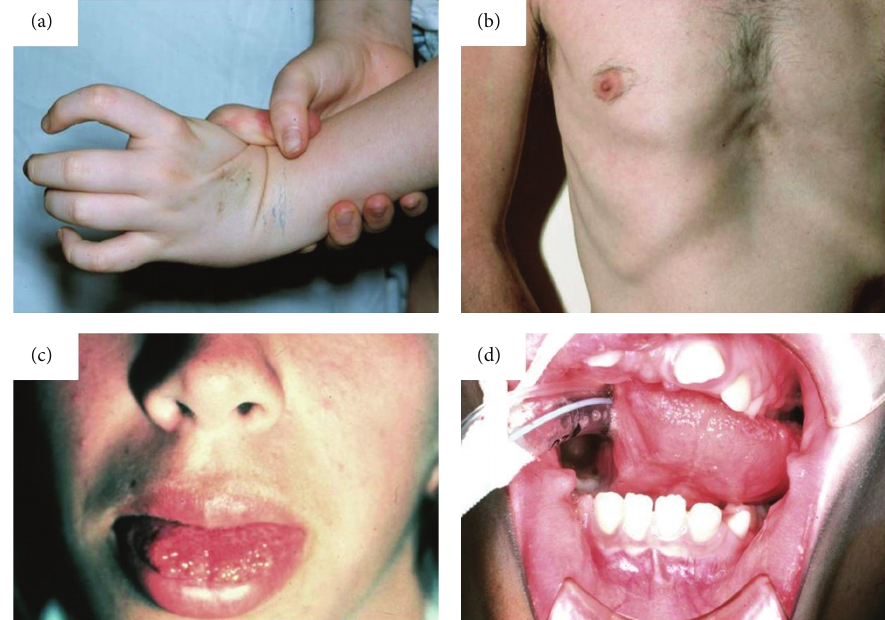
Figure 6: Clinical Features of MEN2B syndrome. Note (a) the laxity in the first metacarpal joint with complete hyperextension causing no pain; (b) typical chest deformity with pectus excavatum; (c) mucosal neuroma in the anterior tongue; (d) abnormal dentition (Reprinted with permission from [52], Copyright Springer Verlag). MEN2B = Multiple endocrine neoplasia type